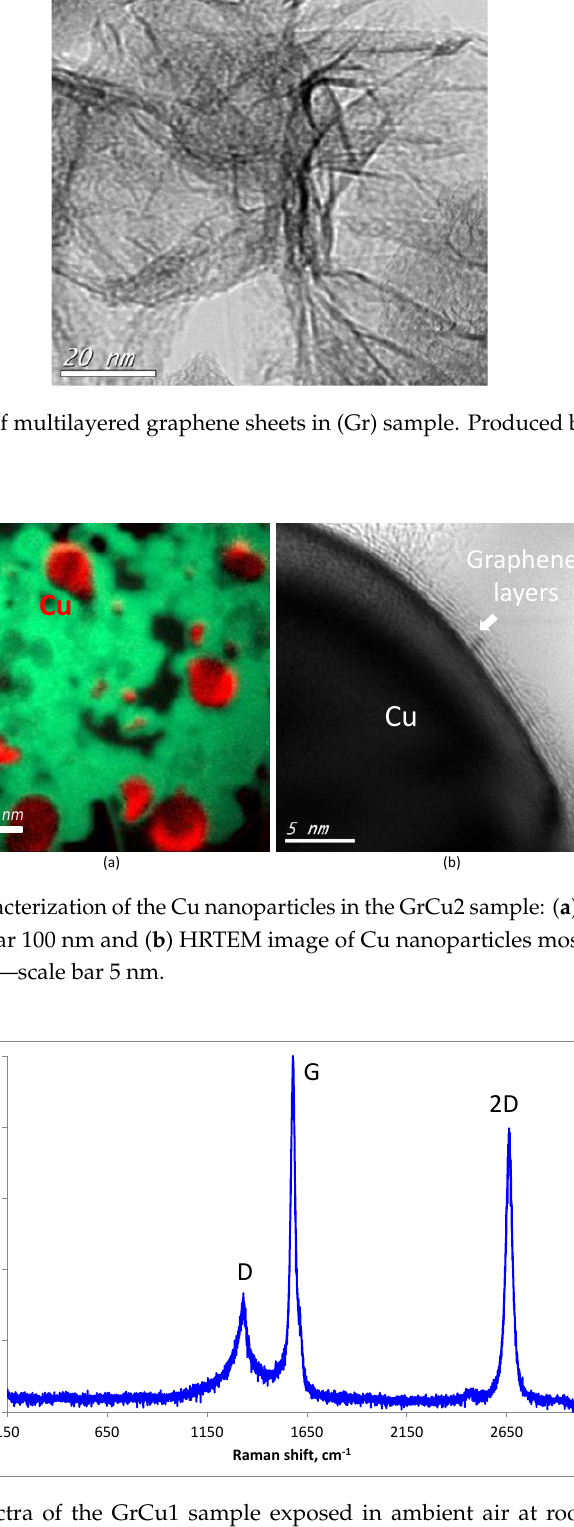
Figure 5. Raman spectra of the GrCu1 sample exposed in ambient air at room temperature for several months.